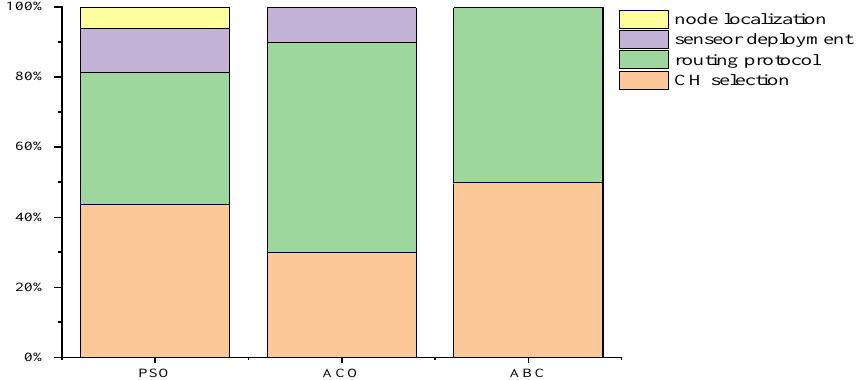
Figure 8. Di ff erent applications for PSO / ACO / ABC in Figure 8. Different applications for PSO/ACO/ABC in WSNs.